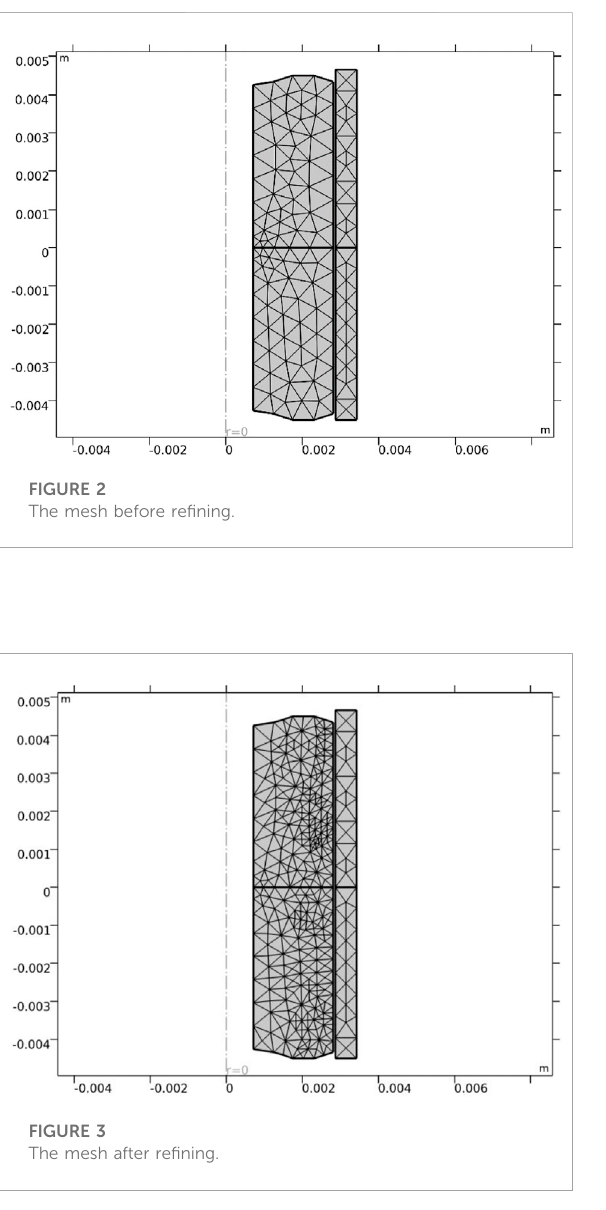
Figure 1 shows a 2D axisymmetric geometry used in this work.